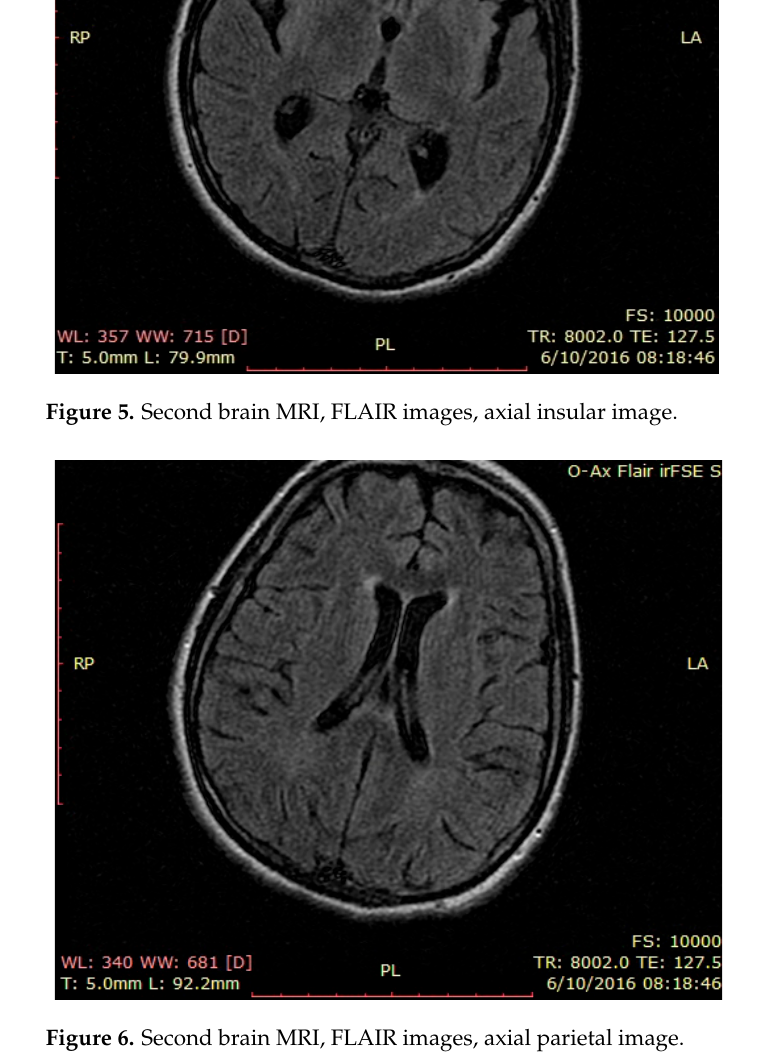
Table S1 Spreadsheet with main clinical and laboratory data.